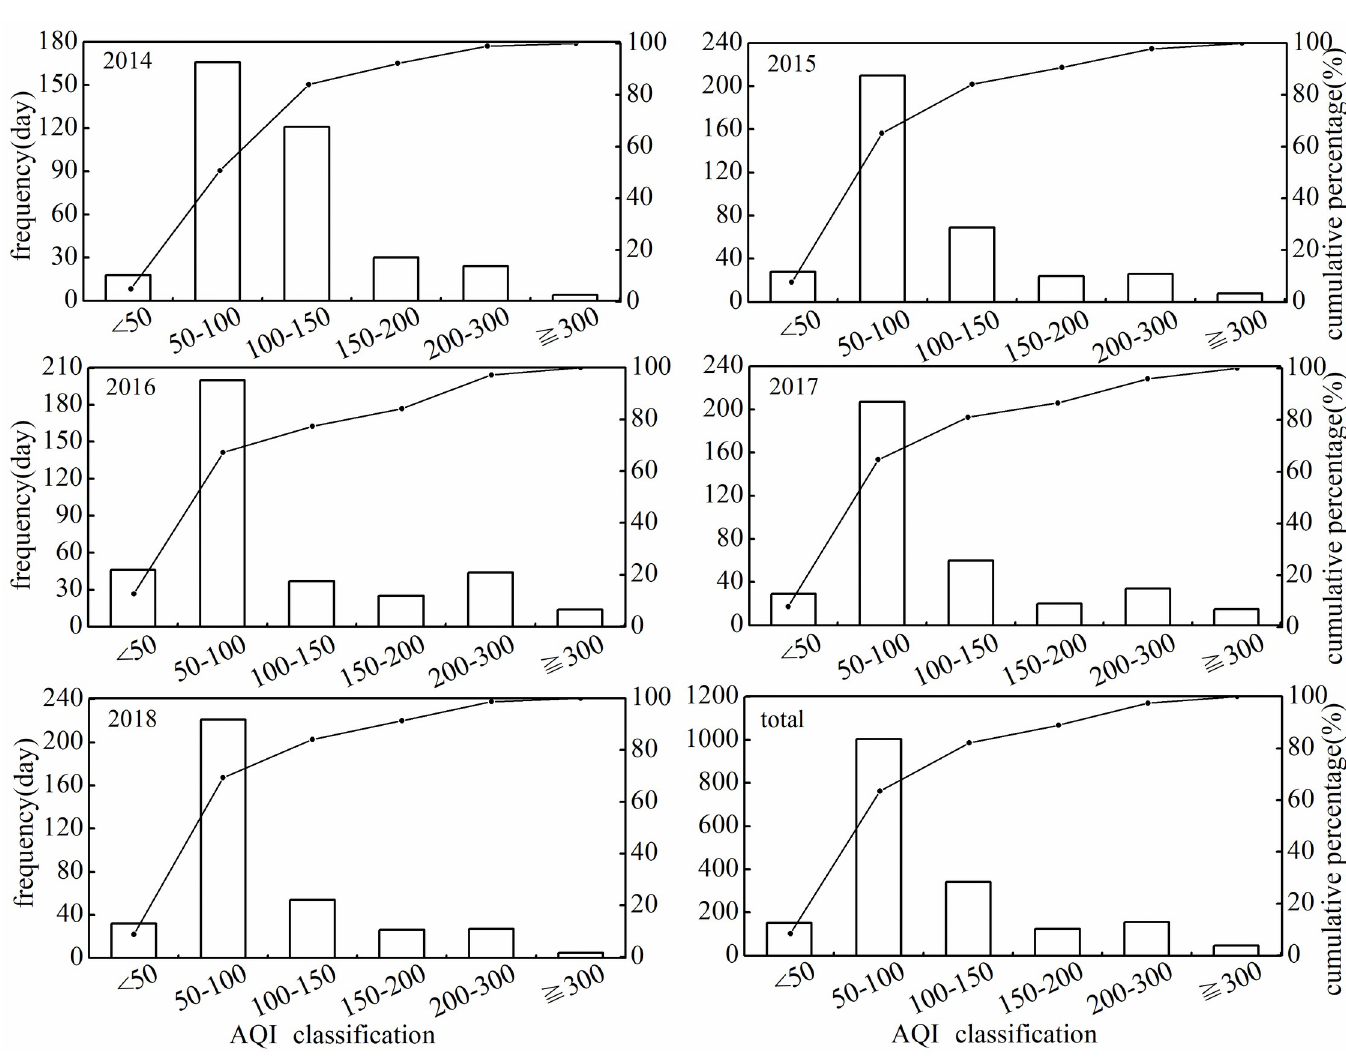
Fig 7. Frequency of pollution levels and cumulative percentage changes.